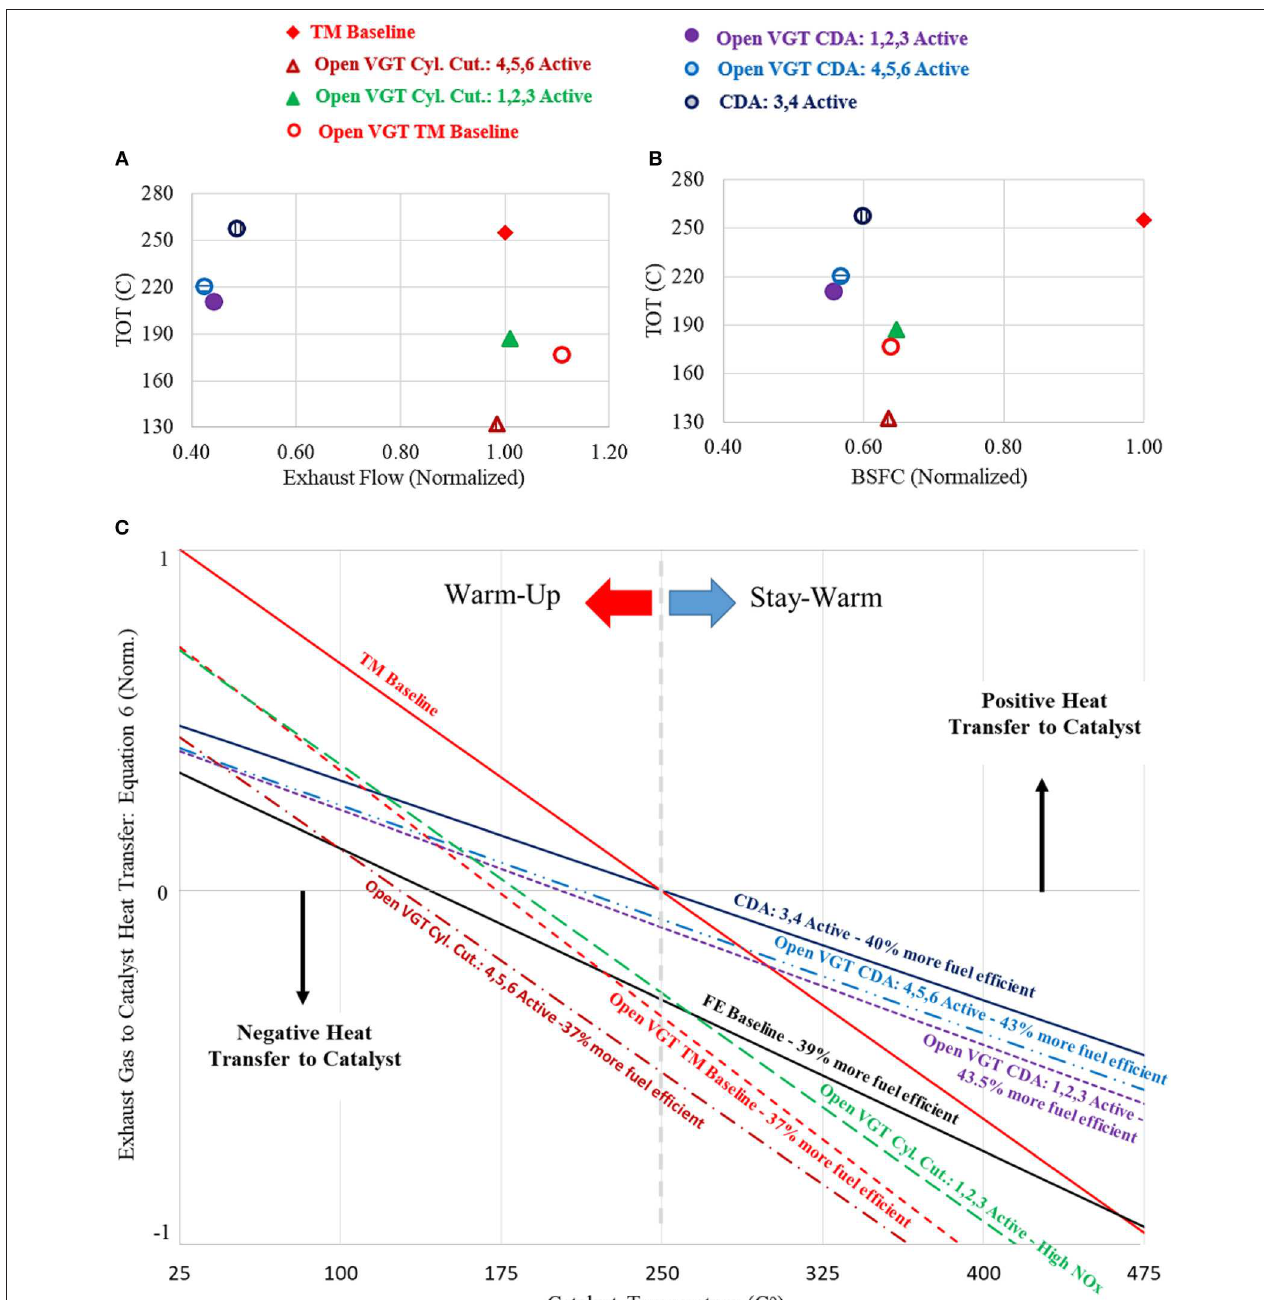
FIGURE 13 | (A) TOT and exhaust flow for each strategy tested with an open VGT setting. Elevated TOT and exhaust flows are ideal for warm-up; whereas low exhaust flows and BSFC are key for stay-warm. (B) TOT and BSFC for each strategy tested with an open VGT setting. (C) Heat transfer rate plots for the open VGT strategies, where the exhaust flow corresponds to the steepness of the slope and the crossing of the zero heat transfer rate axis represents the TOT.